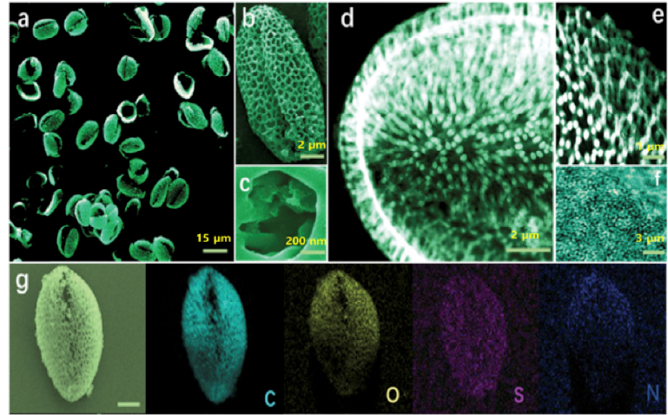
Figure 16. ( a – c ) FESEM, ( d , e ) HAADF-STEM, ( f ) HRTEM images of TRP particle and ( g ) FESEM image and corresponding elemental mappings of a single TRP particle, reprinted with permission from [112].